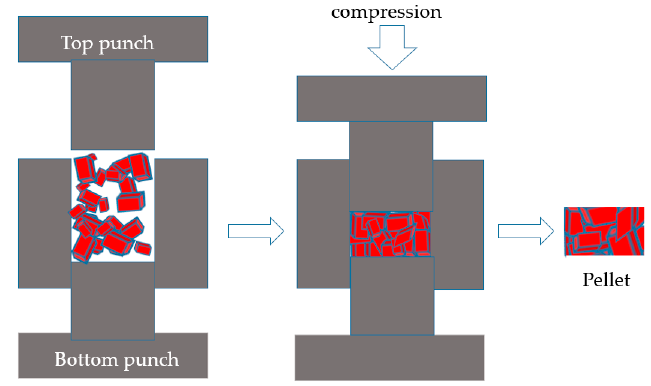
Figure 5. Schematic illustration of a pressing procedure and the formed pellet.